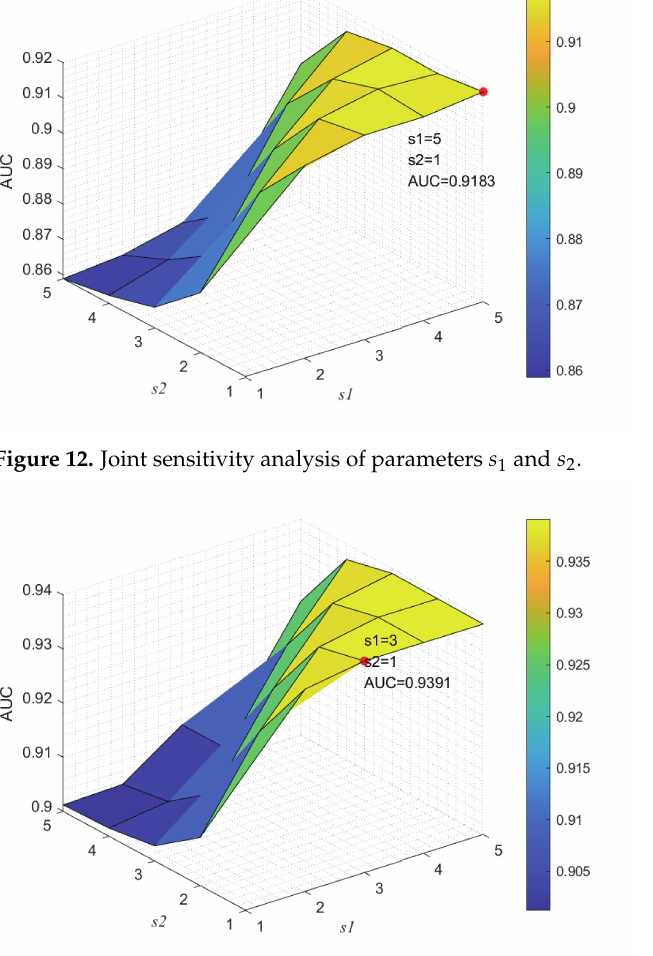
Figure 13. Joint sensitivity analysis of parameters s 1 and s 2